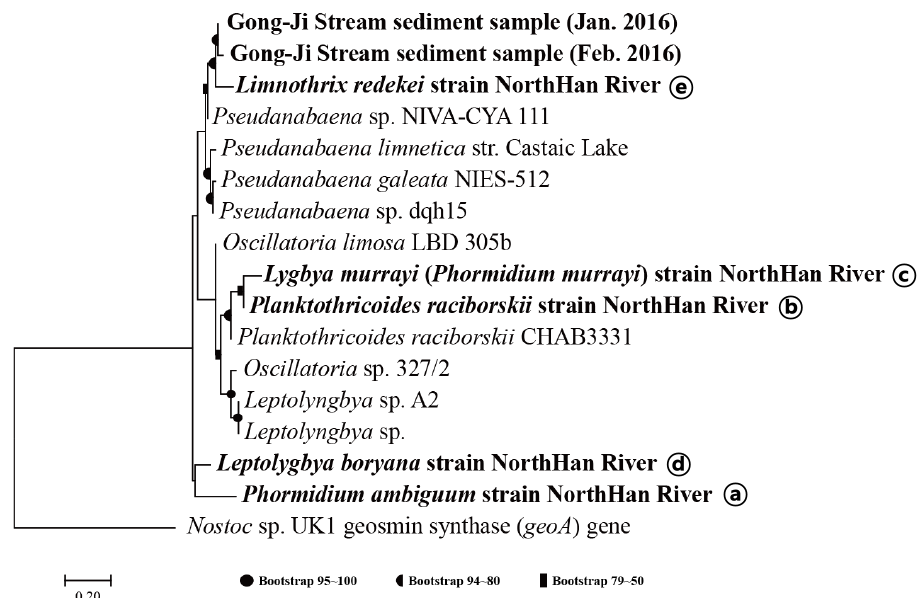
Figure 4. Phylogenic analysis of mibC sequences obtained using the mibC196 primer with sequences from cyanobacterial strains isolated from the North Han River and field sediment environmental DNA samples. The database DNA sequence was downloaded from NCBI GenBank, and the target gene sequence was selected by a keyword search (“ mibC” or “MIB”). Phylogenic analysis of aligned sequences was performed using the maximum-likelihood method (1000 bootstrap replicates). Nostoc sp. UK1 strain was the root species and P. mucicola did not have the mibC gene.